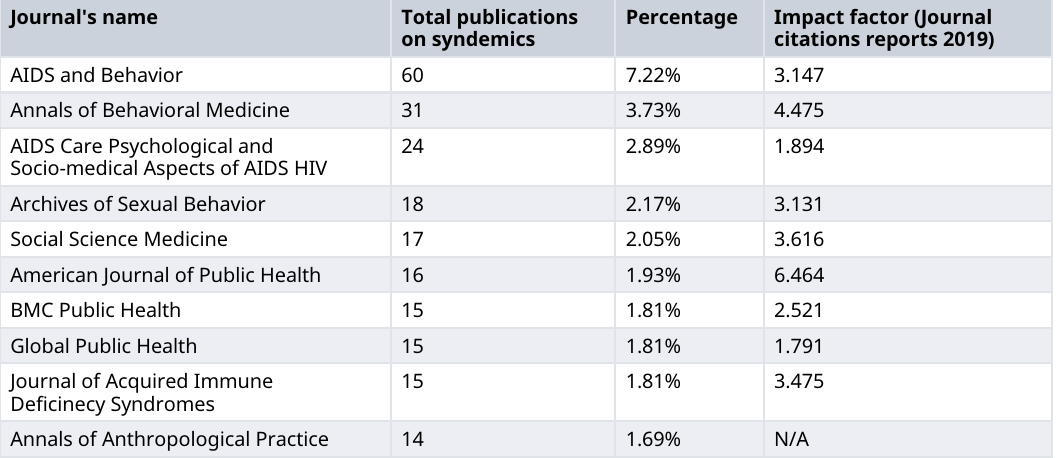
Table 4. Top ten journals publishing syndemics